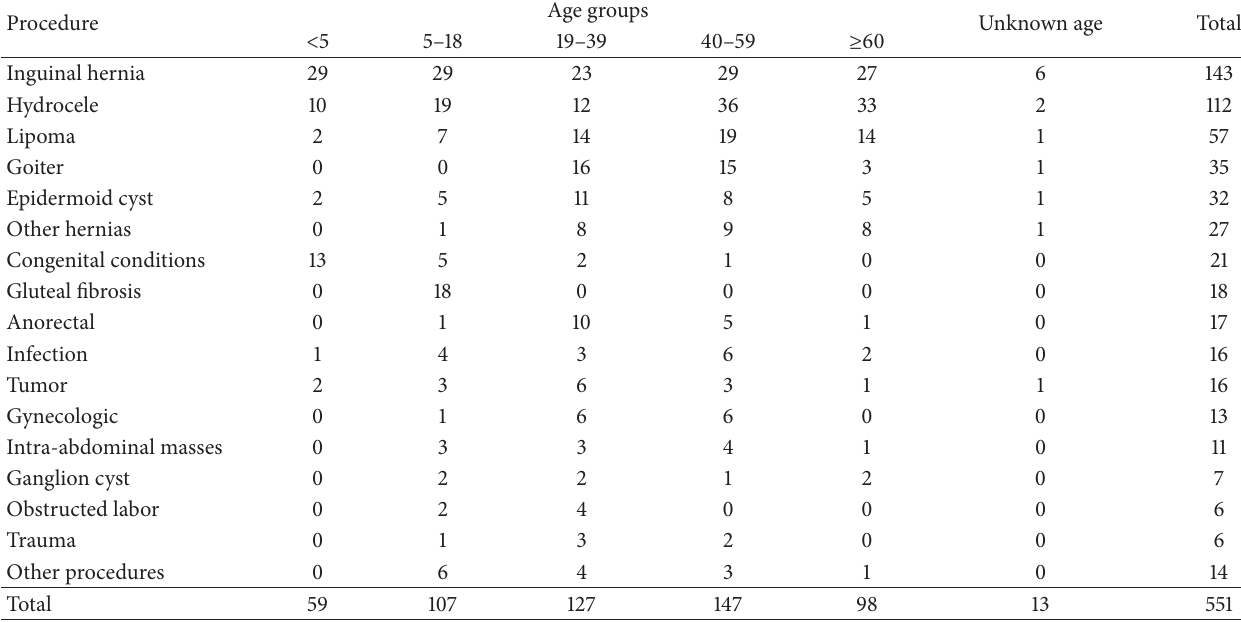
Table 2: Showing diagnosis by age, campsite in Uganda,